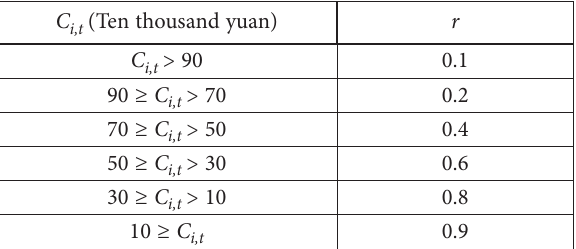
Table 2. Investor agent’s hold funds and weight coefficient